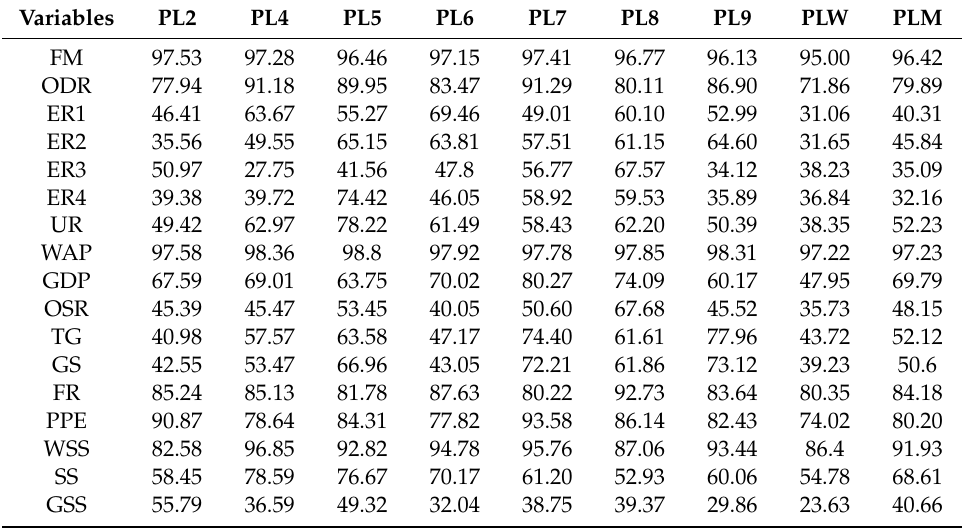
Table 3. Percentage of the average values in maximum values by macro-regions and types of rural areas